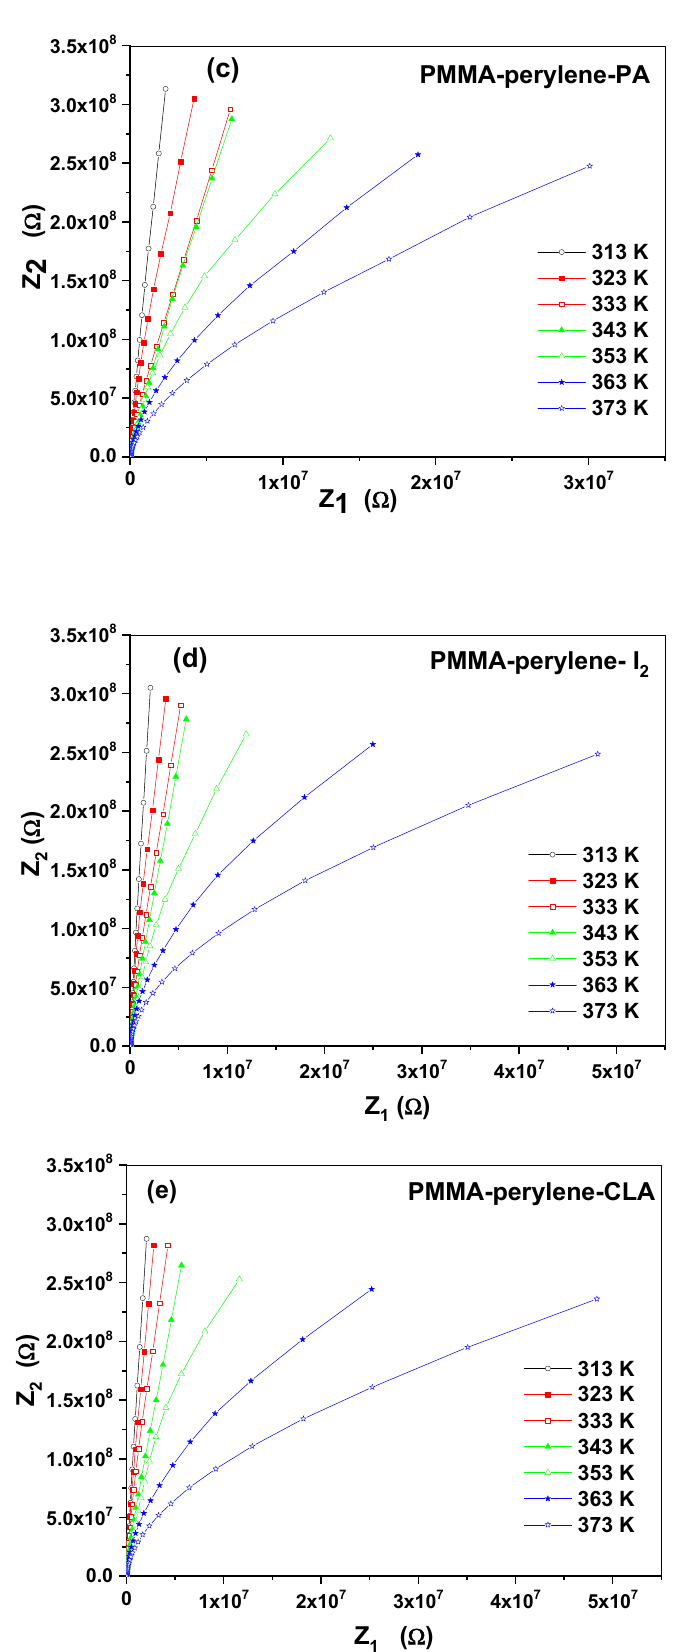
Figure 9. ( a – e ): The complex impedance plot of the synthesized polymeric sheets at different tem- peratures.